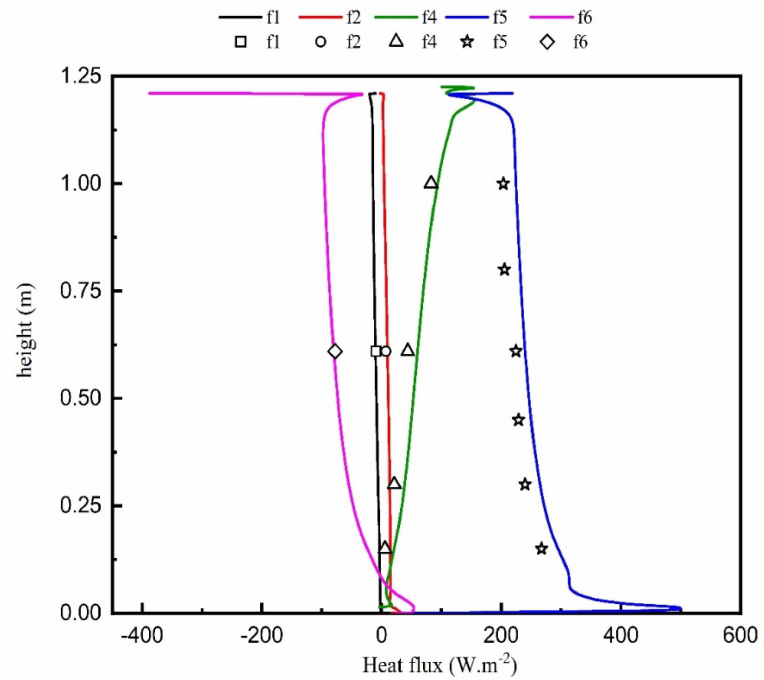
Figure 18. Experimental and numerical heat flux profiles for the three glazings, according to k-w models, P = 320 W.m − 2